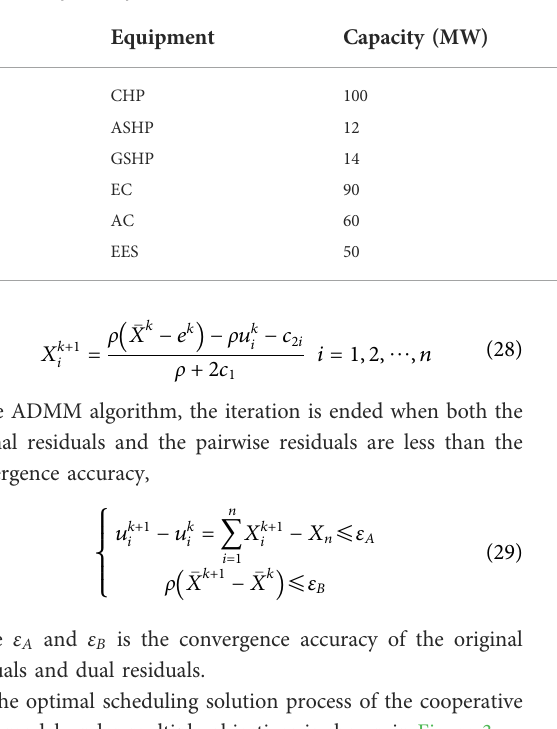
TABLE 1 Component